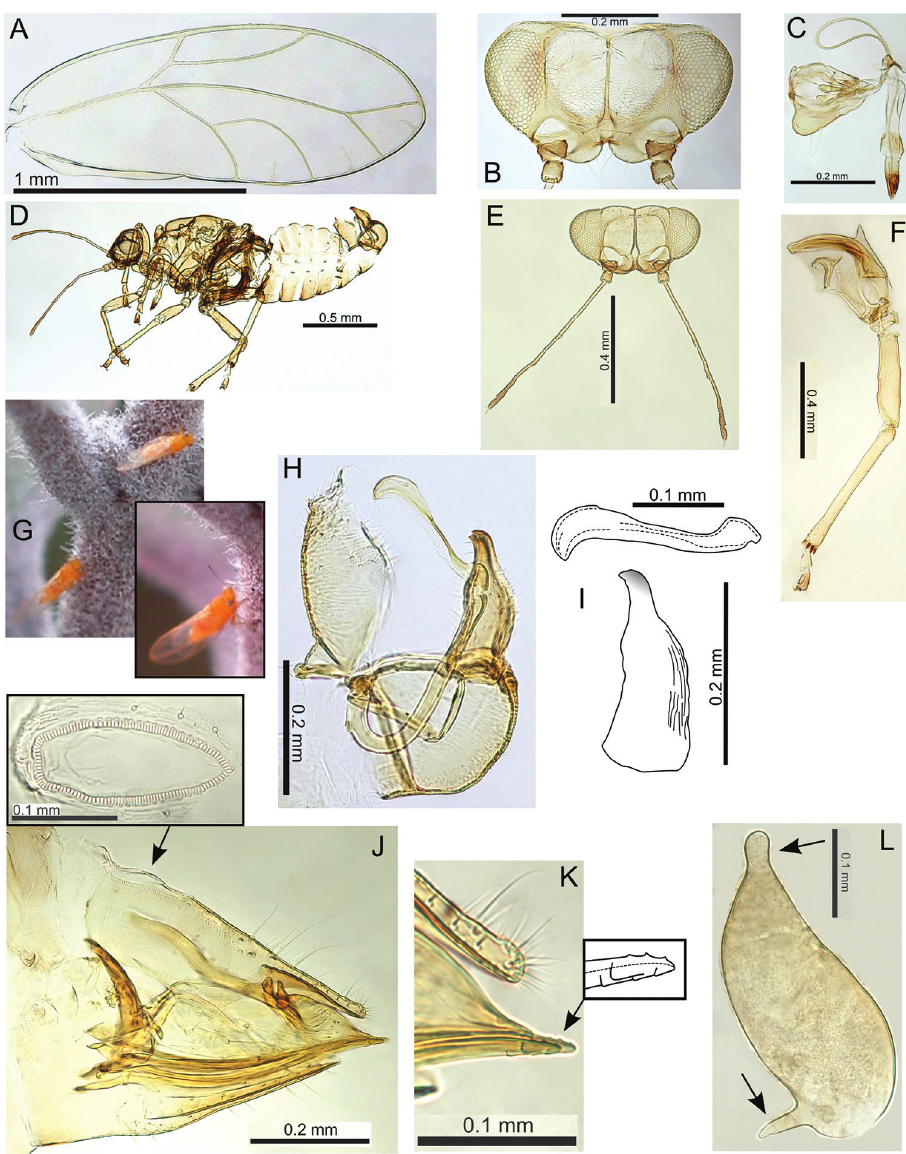
Figure 26. Pariaconus crassiorcalix sp. n. A fore wing B head C proboscis D male E head and antenna F hind leg G adults on pubescent host morphotype H male terminalia I aedeagus and paramere J female terminalia showing anal ring cells (inset) K ovipositor (serrations indicated) L egg (pedicel and tail indicated).